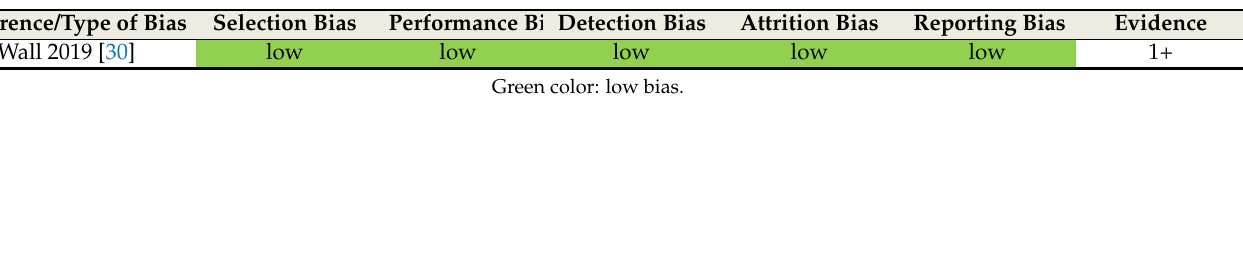
Table A3. Biases from the included